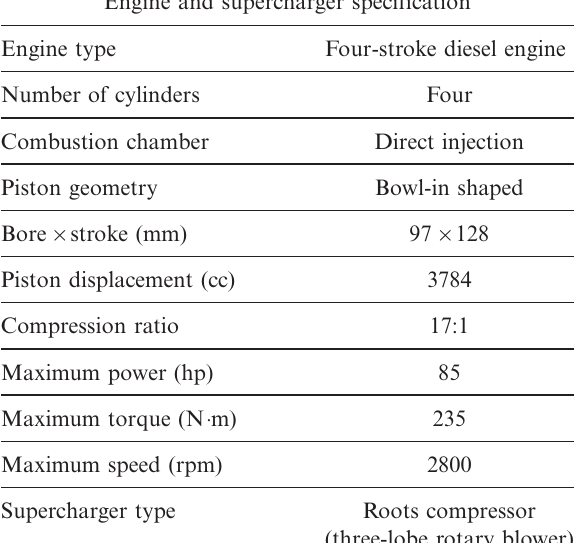
Table 1. OM-314 engine specifications